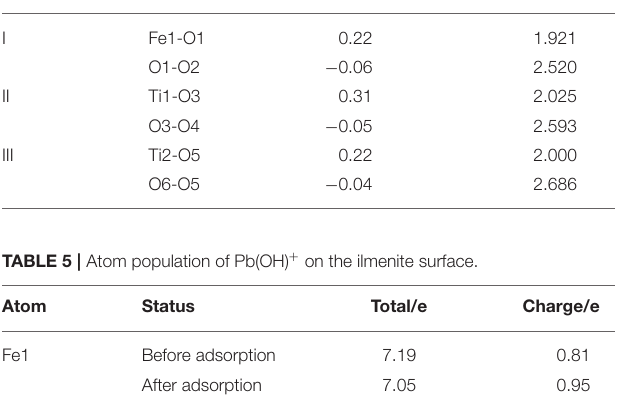
TABLE 4 | Mulliken population of adsorption configuration of Pb(OH) + on the ilmenite surface. Pb(OH) +